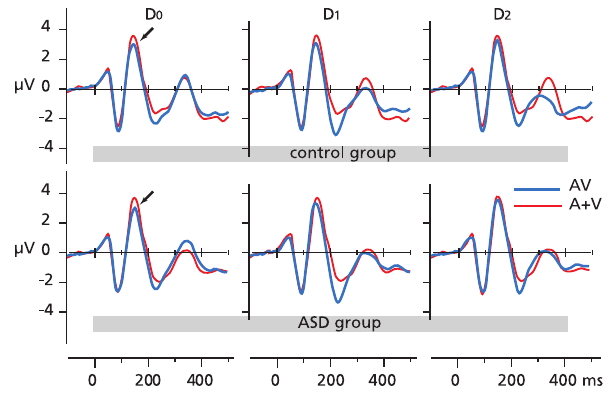
Figure 4. Event Related potentials. ERPs at P7 electrode to congruent visual – auditory fear (FF) and incongruent visual fear – auditory happy (FH) stimuli in the D 0 , D 1 and D 2 conditions from the control group (above) and the ASD group (below). The arrows point to the N170